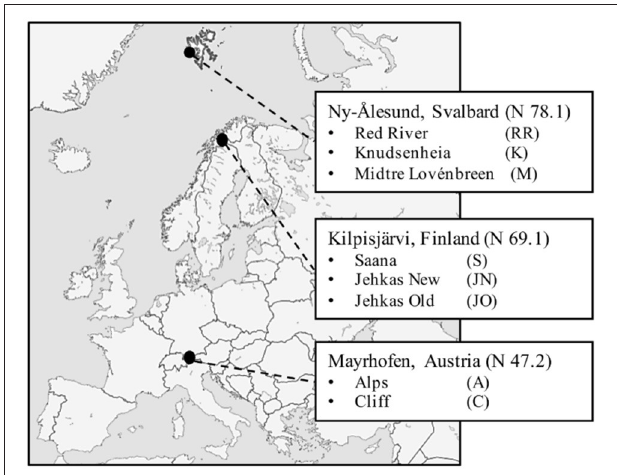
FIGURE 1 | Sampling locations: Mayrhofen in Austrian Alps, Kilpisjärvi in low-arctic Finnish Lapland and Ny-Ålesund in high-arctic Svalbard.